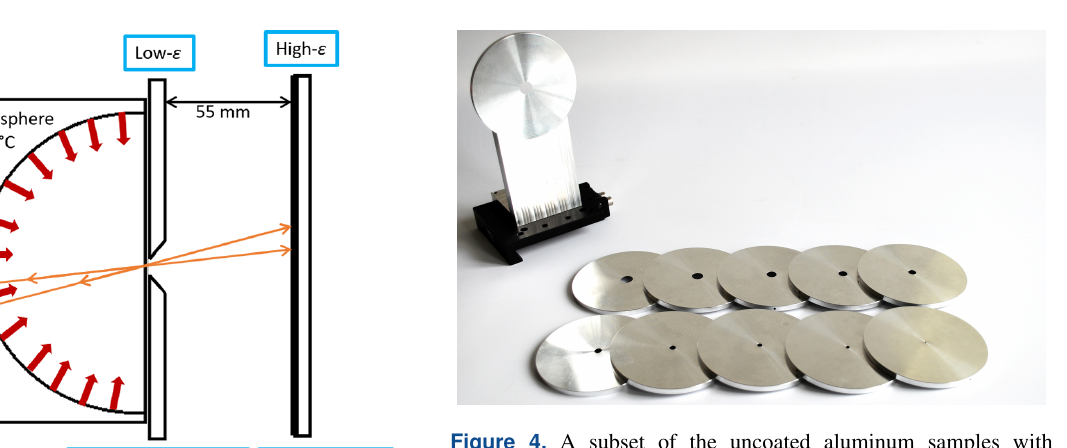
Figure 4. A subset of the uncoated aluminum samples with different-sized